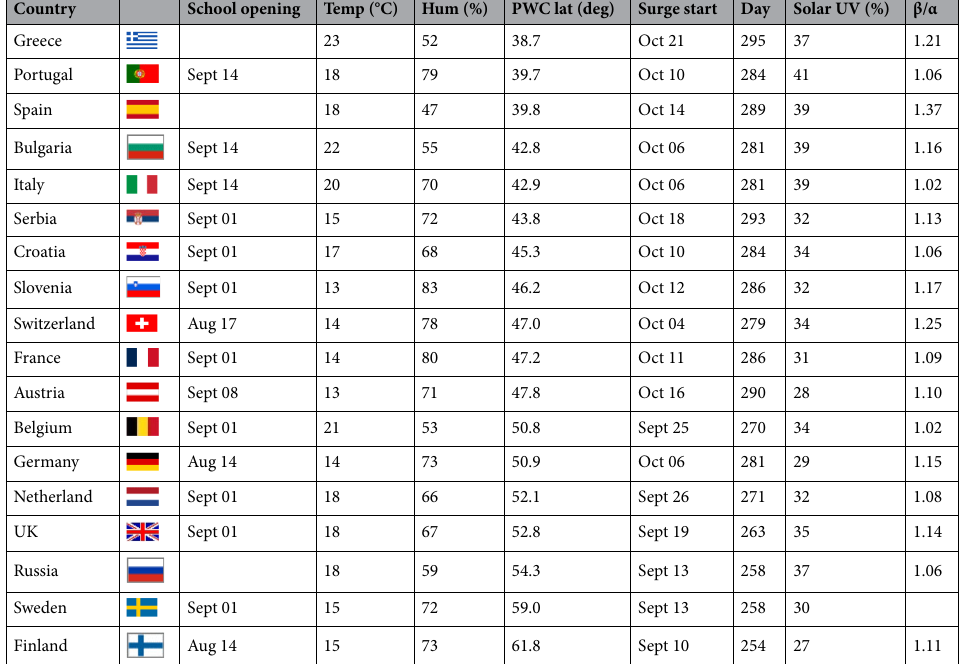
Table 2. Temp, hum: mean country temperature and humidity during the 2 weeks preceding its COVID-19 surge date. PWC lat latitude of the country PWC, Sun UV theoretical sun UV daily dose at the surge date, expressed as a fraction at the PWC latitude versus the latitude 0°.